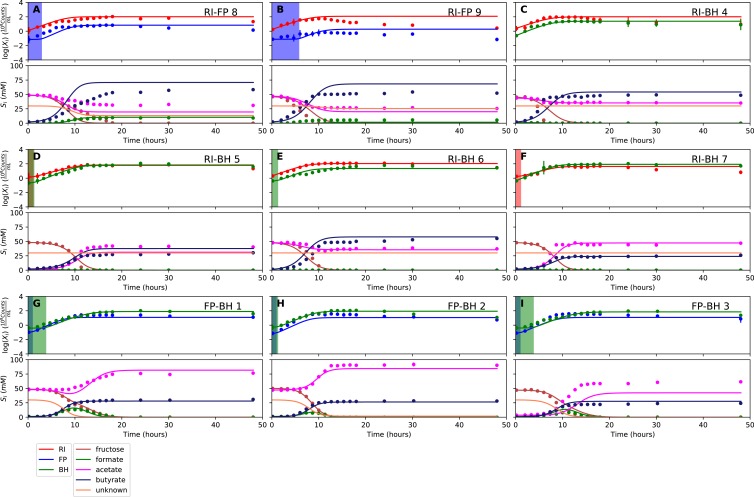
Fit to bi-culture experiments for the model parameterized on selected monocultures and bi-cultures.(A–B) Fit to Roseburia intestinalis L1-82 (RI) and Faecalibacterium prausnitzii A2-165 (FP) bi-culture experiments. (C–F) Fit to Roseburia intestinalis L1-82 and Blautia hydrogenotrophica S5a33 (BH) bi-culture experiments. (G–I) Fit to FP and BH bi-culture experiments. Lines represent model predictions and dots represent observations. The shaded regions indicate the length of the estimated strain-specific lag phases. The whiskers represent technical variation across triplicates. The unknown compound represents an unspecified co-substrate assumed to be required by FP. Metabolites not included in the model are omitted from the plot. Experiment identifiers indicate which of the biological replicates is displayed. The model was parameterized on experiments FP_4, FP_15, FP_BH_1, FP_BH_2 and RI_BH_4.